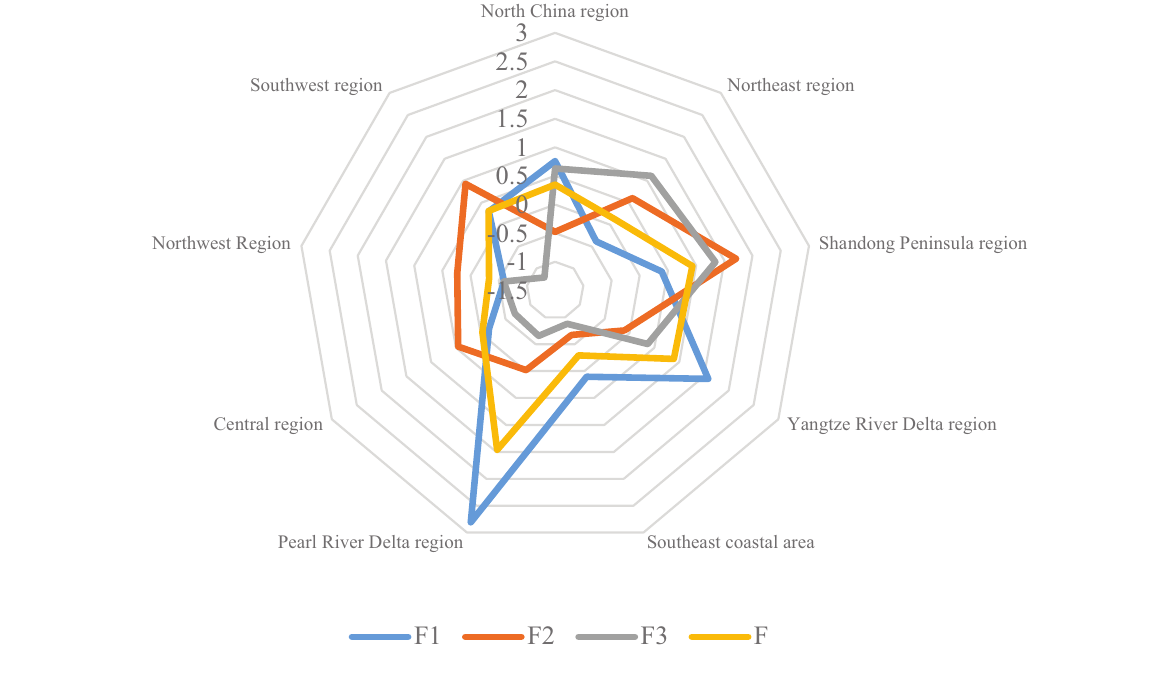
FIGURE 1 | The comprehensive score of the nine major logistics